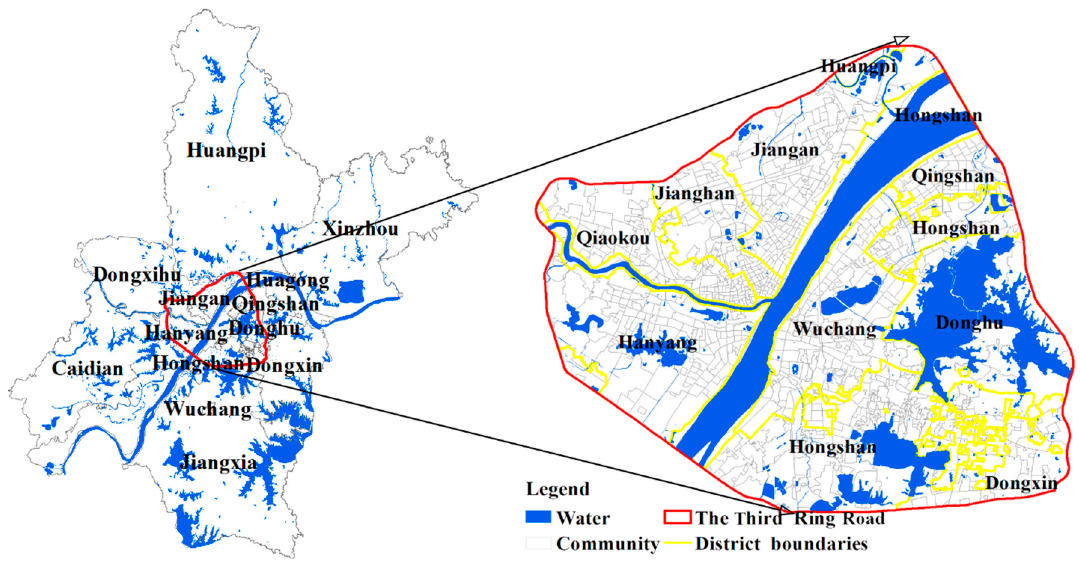
Figure 2. The study area.